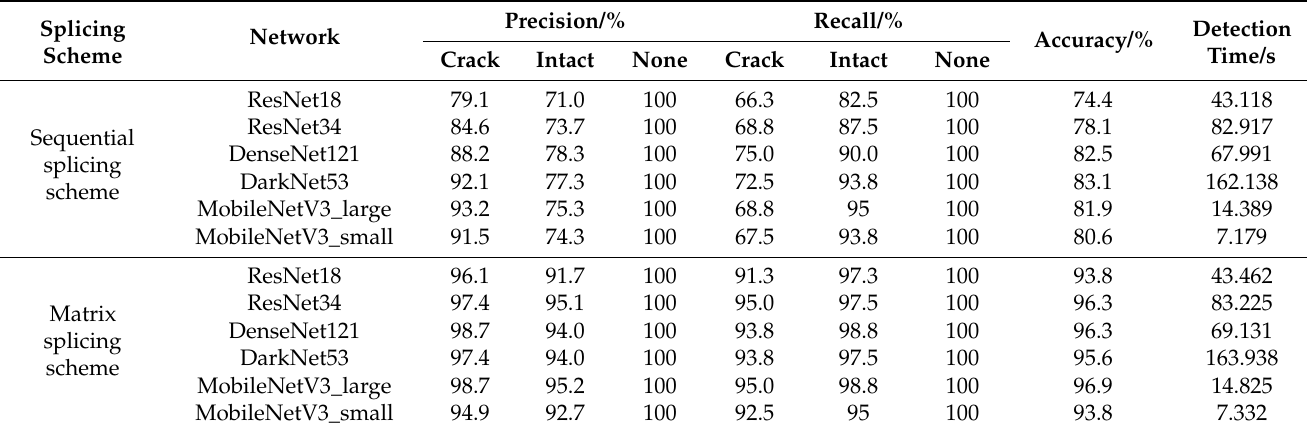
Table 3. The training results of different models under the two splicing